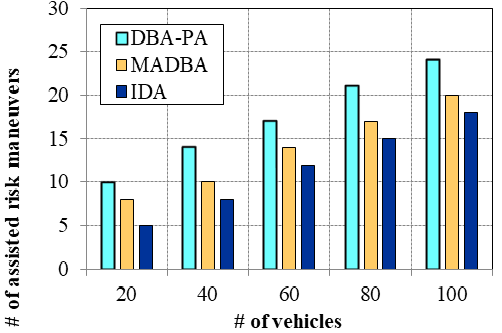
Figure 7. Number of Vehicles vs. Number of Assisted Risk Maneuvers.